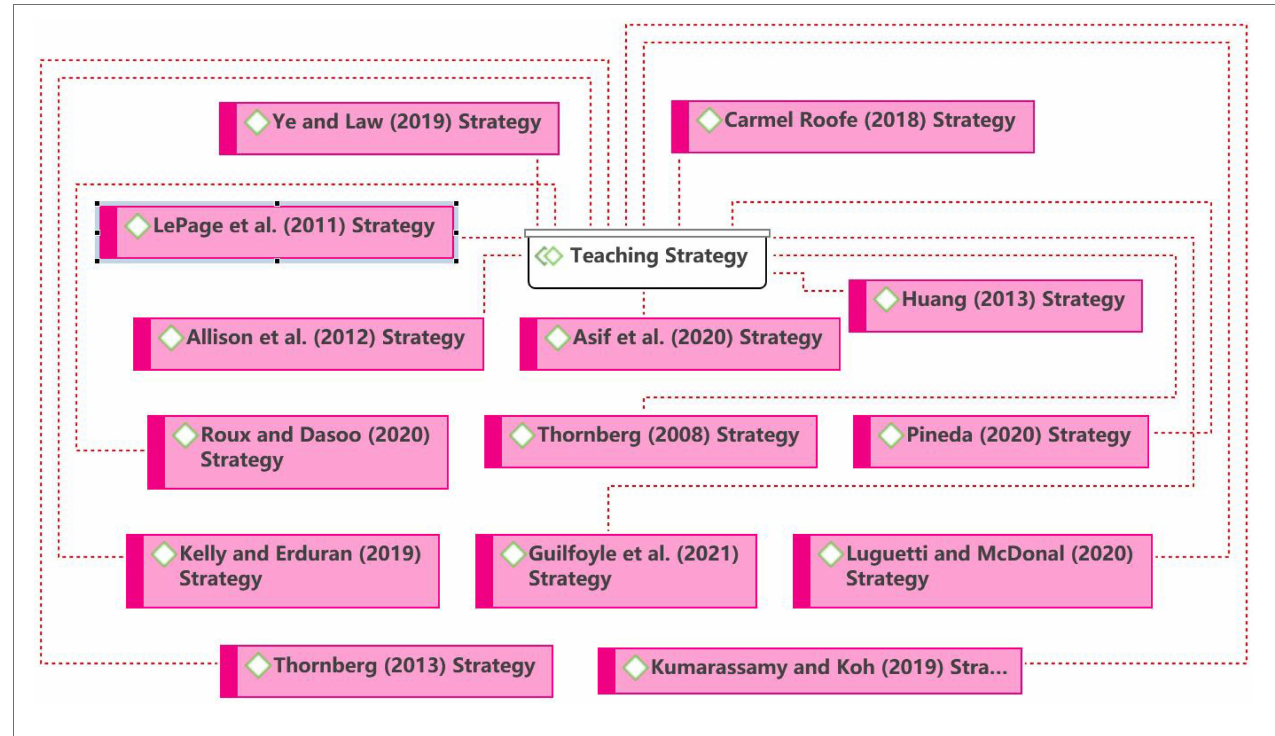
FIGURE 7 | Network on the teaching strategy